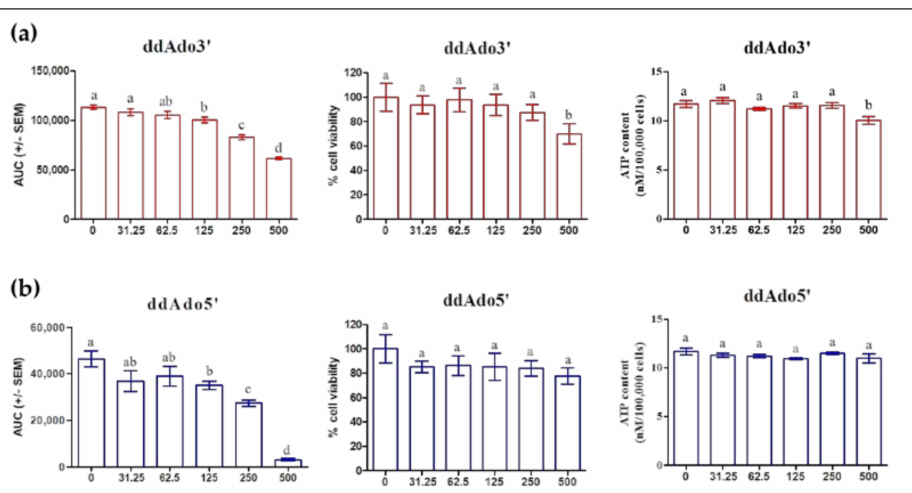
Figure 5. Effect of ddAdo3 (cid:48) ( a ) and ddAdo5 (cid:48) ( b ) on the intracellular cAMP response to 0.7 nM hLH, on the cell viability and ATP concentration. Cells were treated with various concentrations (0, 31.25, 62.5, 125, 250, 500 µ M) of ddAdo3 (cid:48) or ddAdo5 (cid:48) for 1 h. The values are means ± SEM for n = 3 independent experiments. p value of <0.05 was considered statistically significant using a one-way ANOVA followed by the Dunnett’s test post-test. Different letters indicate significant differences between control (0 µ M) and treatment at p < 0.05.